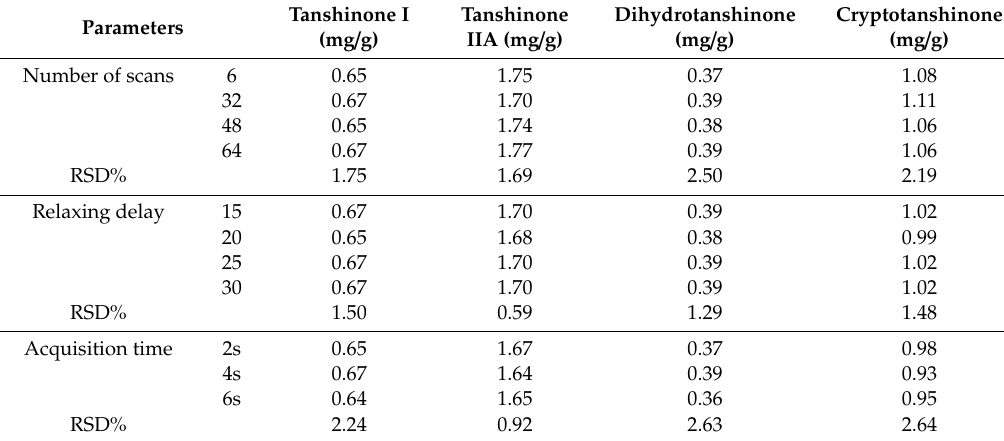
Table 5. Results for robustness